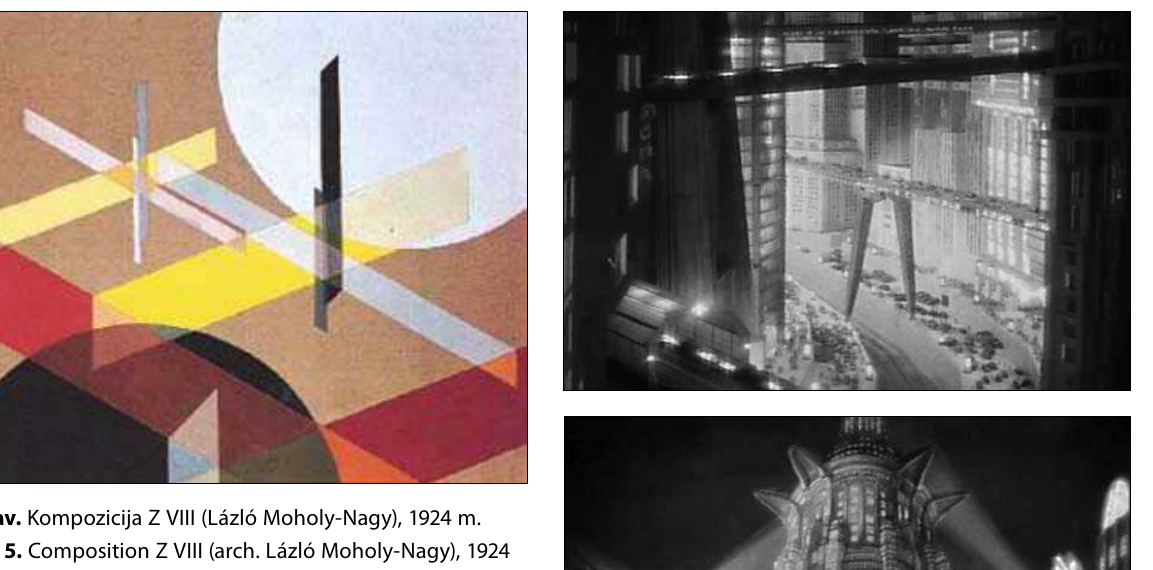
Fig. 5. composition Z VIII (arch. Lázló Moholy-Nagy), 1924